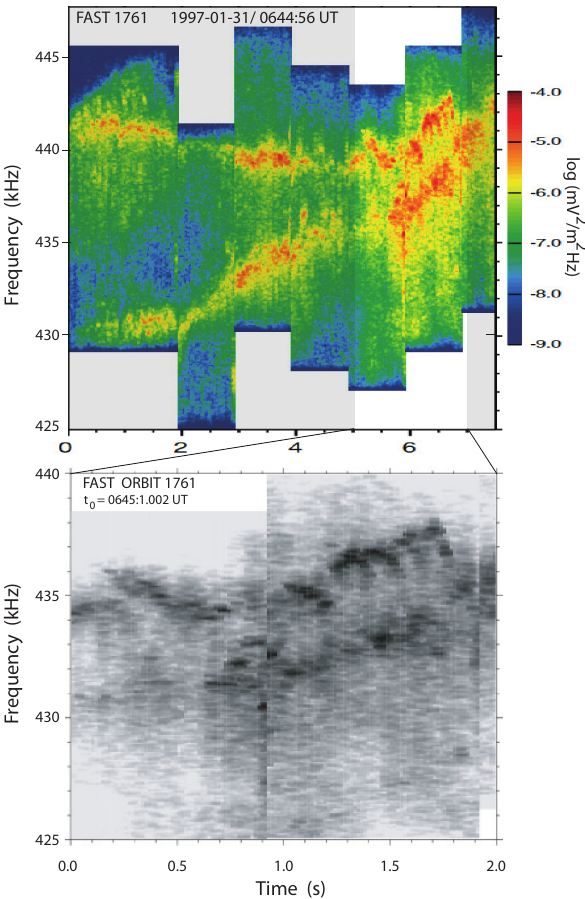
Fig. 1. An example of two drifting auroral kilometric radiation emission bands (FAST orbit 1761) consisting of narrow fine struc- tures. The expanded high-time resolution dynamic spectrum of the unshaded part of the spectrum is shown in the lower panel (re- scaled data taken from Pottelette et al., 2001). Time resolution is 1t = 33ms. The two approaching emission bands consist of many individual “elementary radiation structures”. The upper band shows towards the end of the observation shows indications of turnovers of some of the elementary structures. The limited time resolution does not allow for an unambiguous determination of the individ- ual frequency drifts. In the turnovers the frequency drift is zero. Simultaneously, the spectral energy density maximises. The high- est power flux in those single 1 kHz bandwidth events amounts to P ∼ 10 − 7 Wm − 2 (or energy density W ∼ 10 − 15 Jm − 3 ). Since the emission frequency should be related to the location of the radiation source along the magnetic field via the electron cyclotron frequency, the drift of the two bands suggests reflection at a layer located at higher magnetic field strengths and is moving slowly downward.